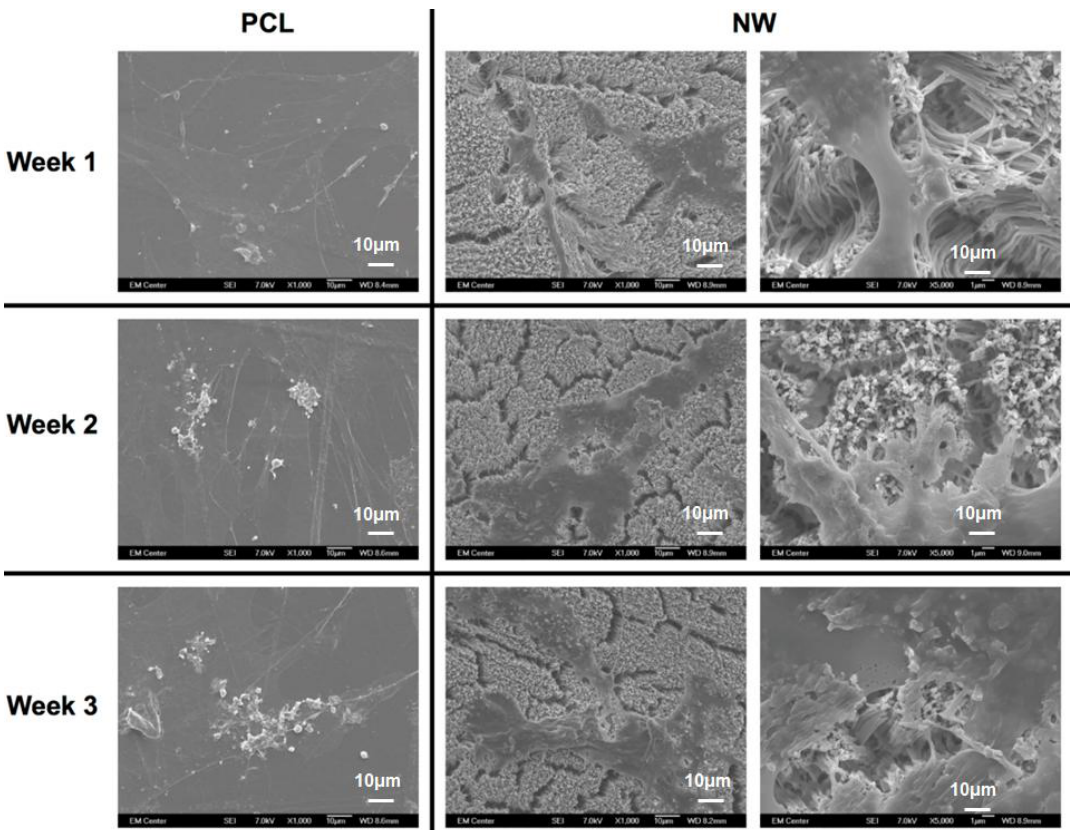
Figure 14. Representative SEM images of ADSCs on PCL and NW after 1, 2, and 3 weeks of culture in adipogenic